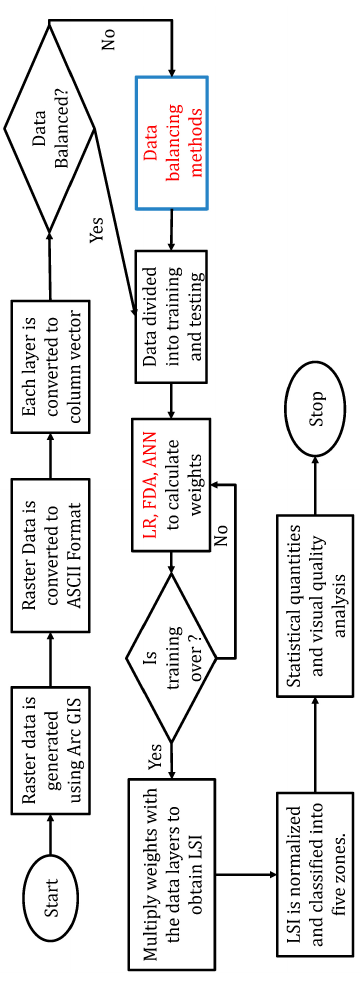
Figure 2. Flowchart of the study